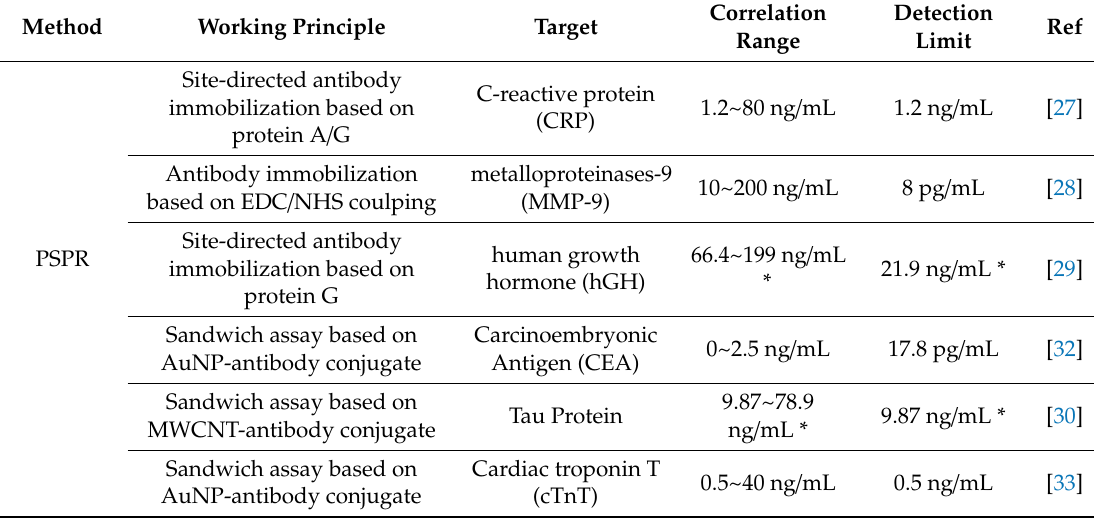
Table 1. Comparison of SPR and LSPR-based immunosensors for protein biomarker detection.